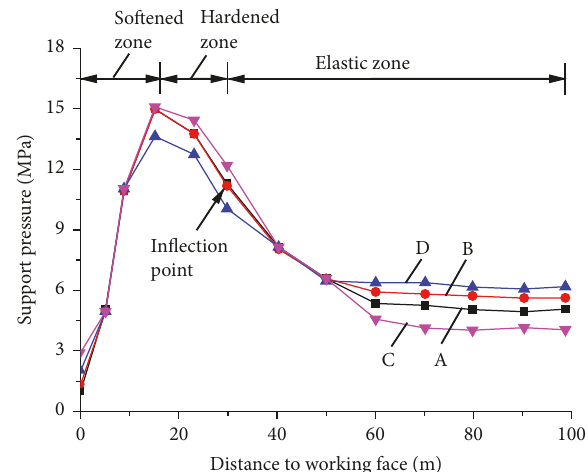
Figure 1: Distribution picture of support pressure of each measured points [21].